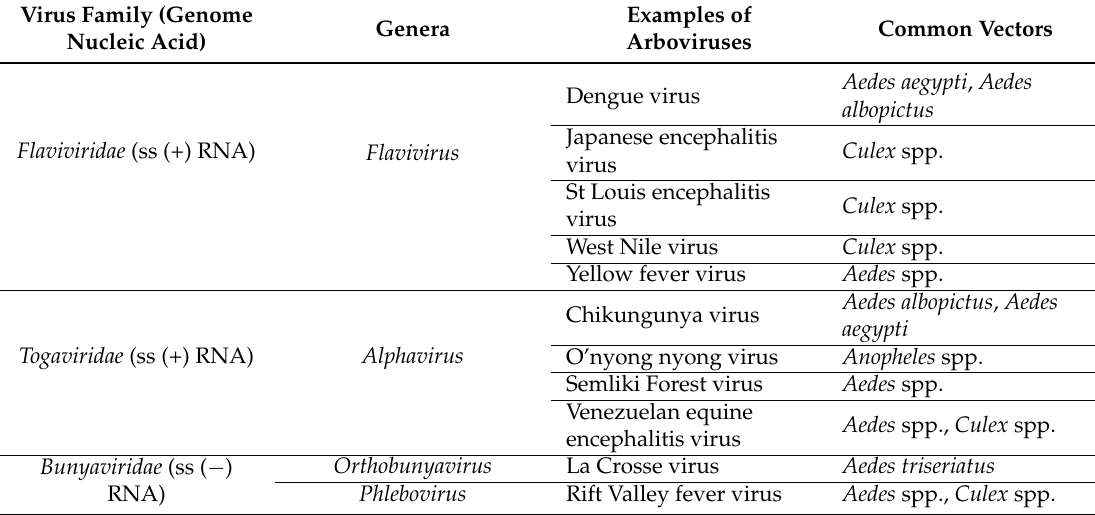
Table 1. Mosquito vectored arboviruses and their common vectors